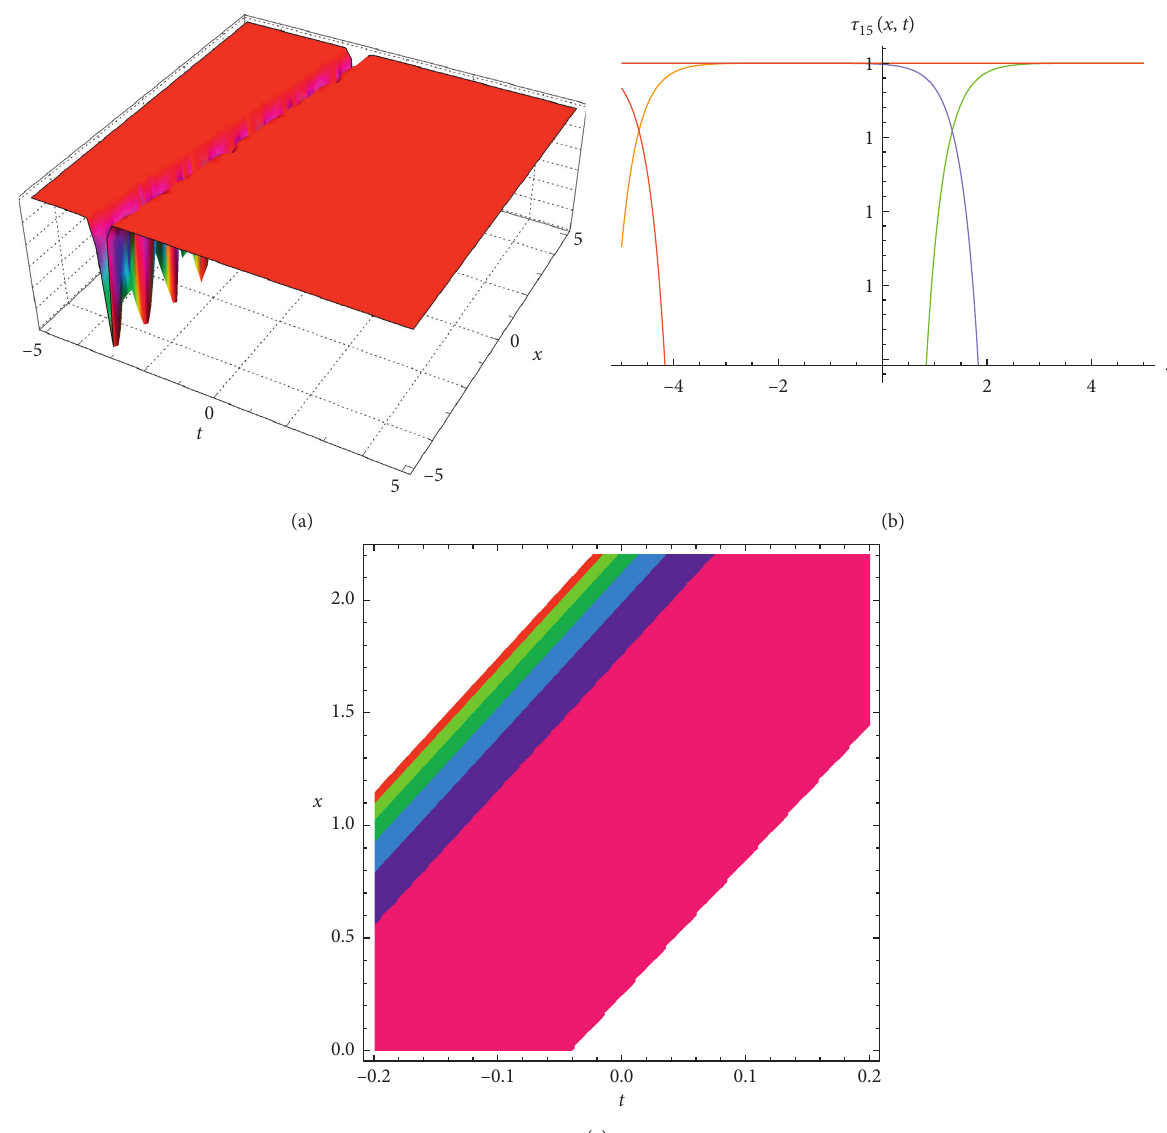
Figure 2: Solitary wave in three different forms of equation